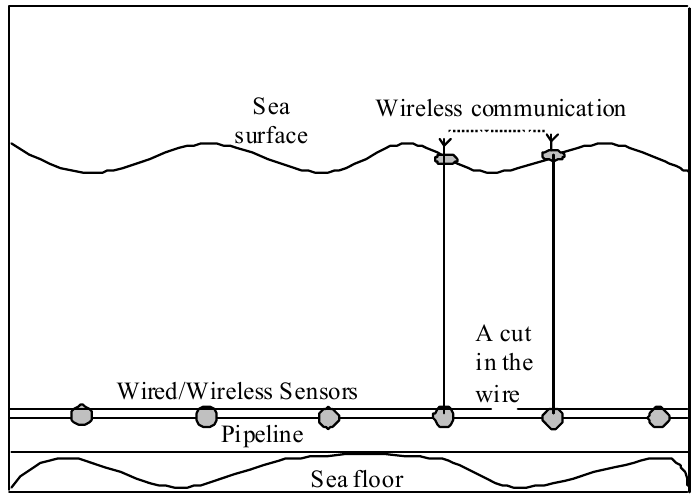
Figure 7. Integrated wired/RF wireless sensor